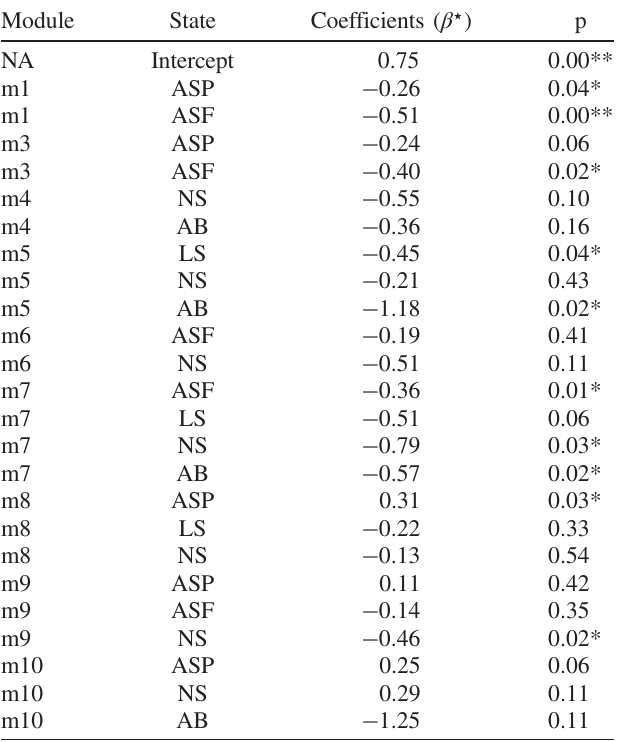
TABLE V. Estimated coefficients and p values of regression (4) for the six-state model (level